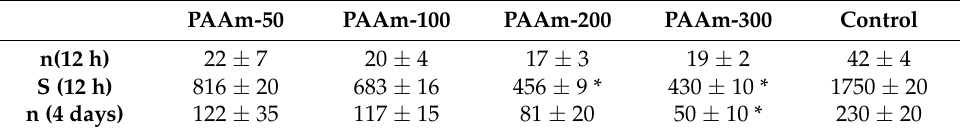
Table 4. The results of the evaluation of the adhesive and proliferative activity of human fibroblasts on the surface of PAAm gels with different crosslinking density. n—the average number of adhered cells in the field of view for 12 h and four days after seeding; S—the average area (in square micrometers) of the adhered cells for 12 h after seeding; The results are presented as M´ ± m ( n = 30). Asterisks reflect significant differences ( p < 0.05) of the corresponding indicators with PAAm-50 and PAAm-100 gels.